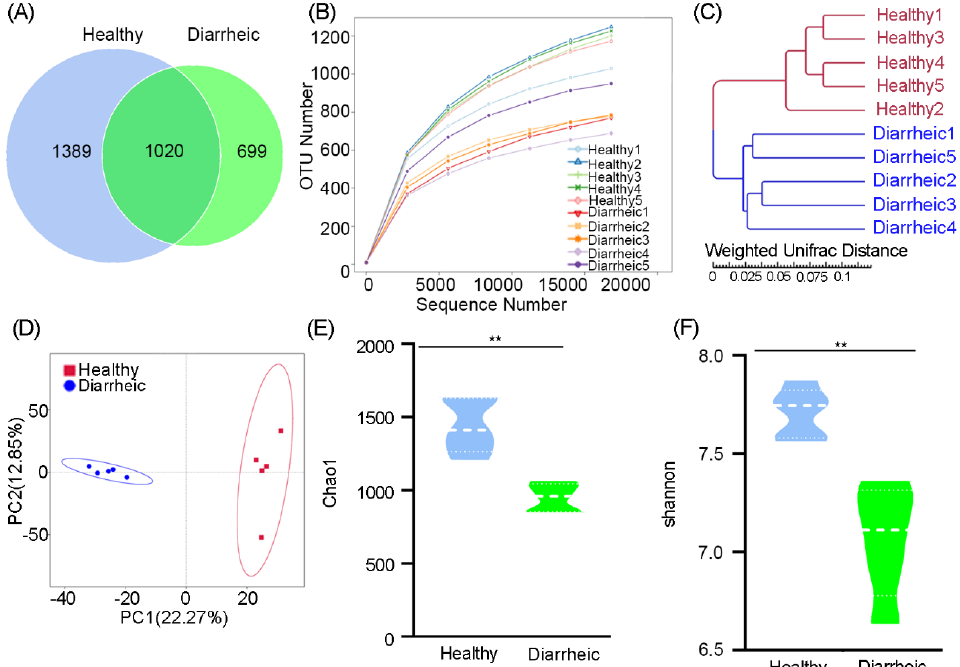
Figure 1. Gut bacterial OTU distribution, feasibility, and diversity analyses. ( A ) Venn diagram showing OTU composition. ( B ) Rarefaction curve showing sequencing quality based on OTU abundance. ( C ) Clustering based on weighted UPGMA analysis. ( D ) PCA score plots of OTUs. α -Diversity comparisons based on Chao1 ( E ) and Shannon indices ( F ). Data were presented as the mean ± SEM ( n = 5 animals/group). ** p < 0.01.